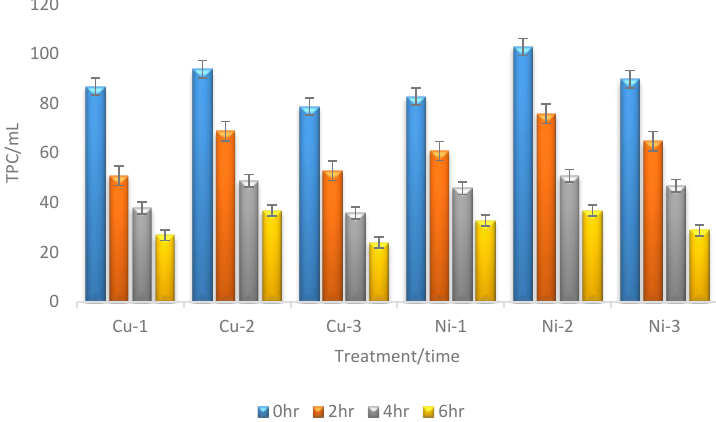
Fig. 11. Graphical presentation of nanoparticle coated antimicrobial discs and standard antibiotic discs against Staph. aureus and E. coli